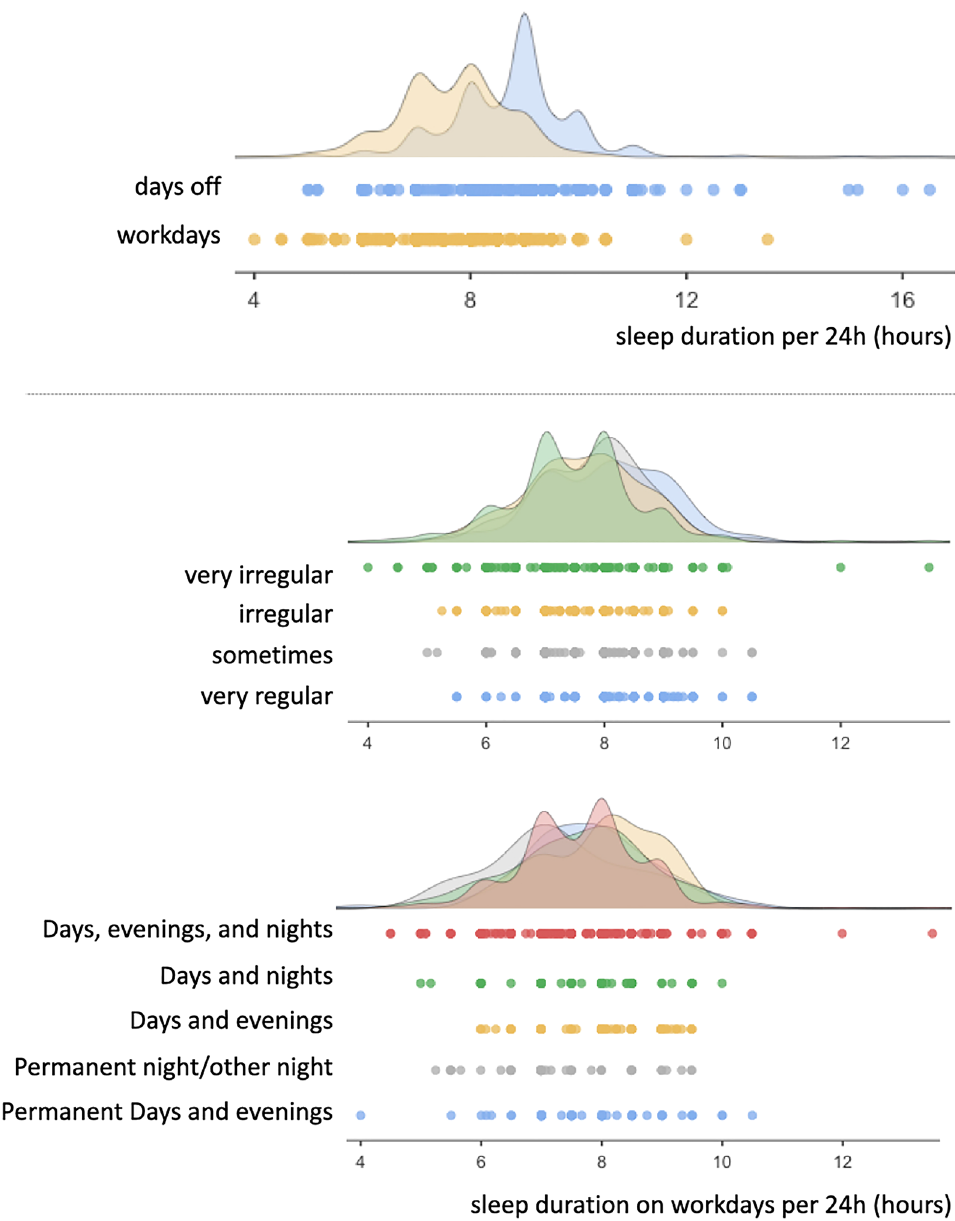
Figure 2. Adapted raincloud plots for sleep on days off compared to workdays (upper) and sleep on workdays split by schedule regularity and by shift pattern